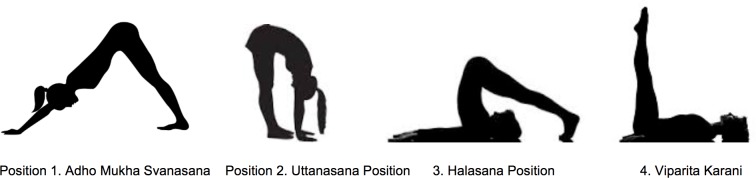
Scheme Illustrating the Various Yoga Positions.